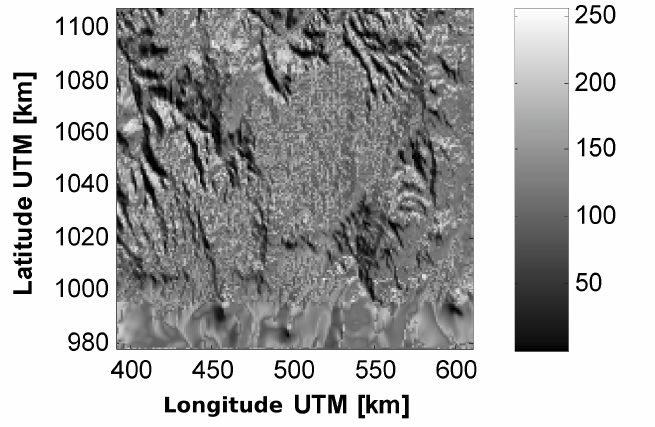
Figure 2. Full grayscale bitmap of aspect of the region terrain.